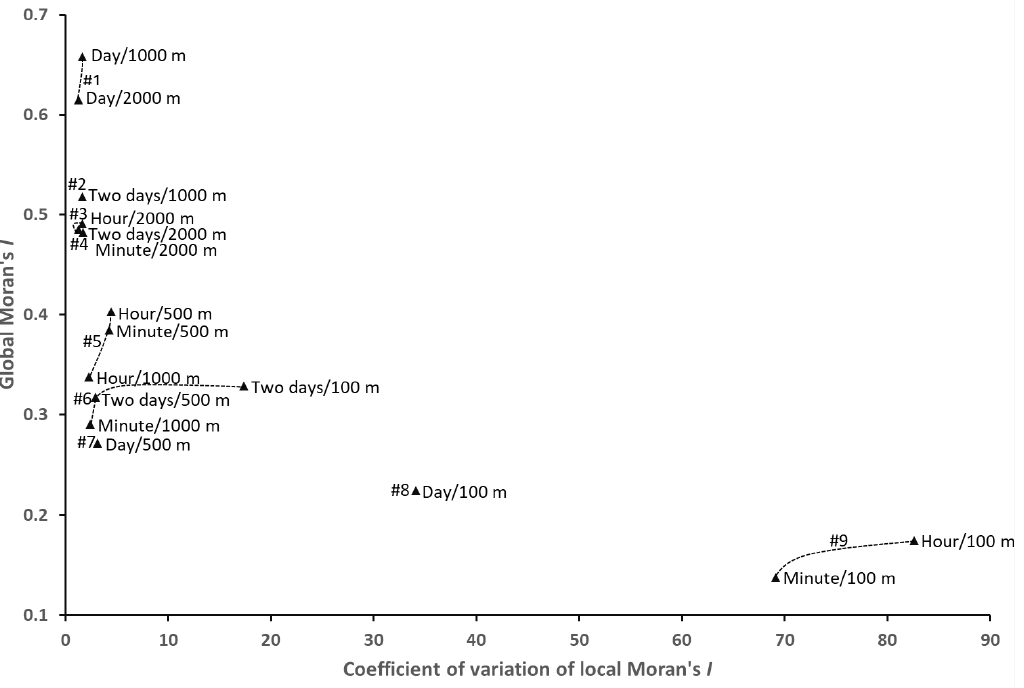
Figure 6. Pareto boundaries based on global and local spatial correlations (#1–#9 are Pareto boundaries). Table 3. Global and local spatial correlations and corresponding Pareto boundaries for each spatiotemporal analysis unit.